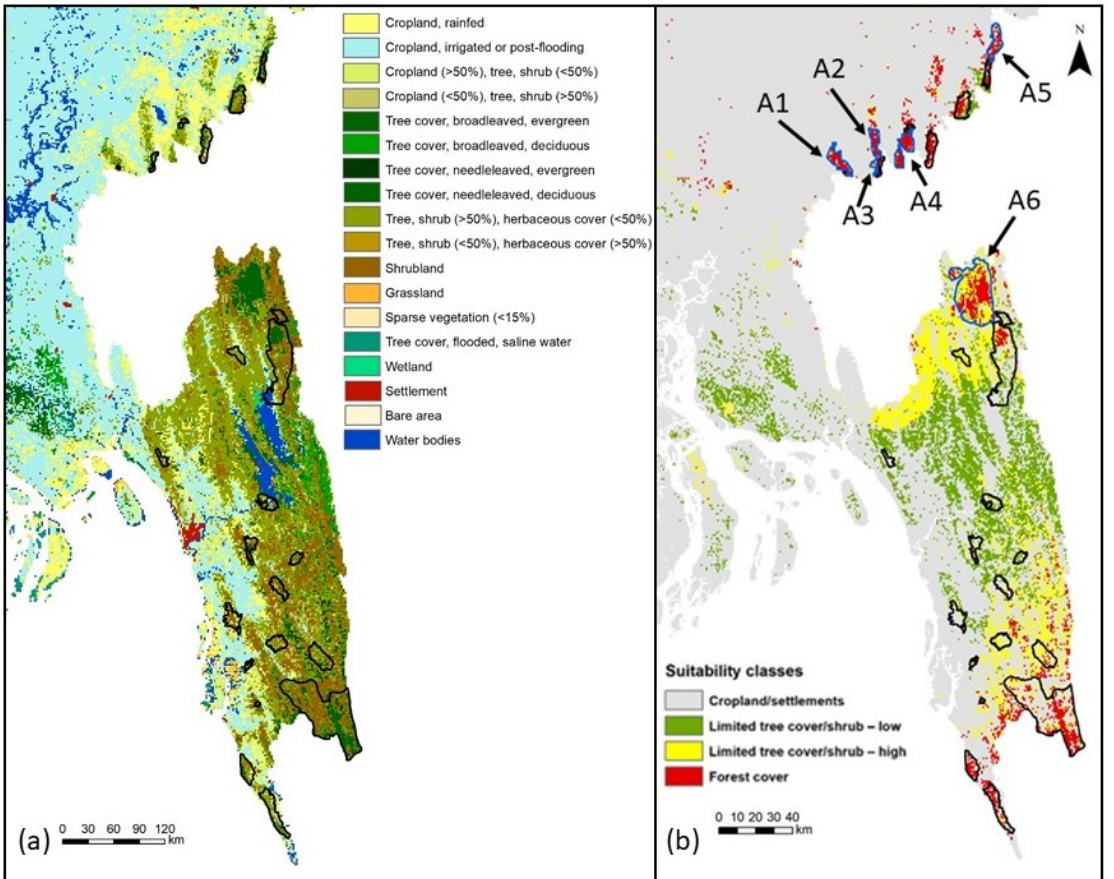
Figure 3. ( a ) Map showing forest distribution in eastern Bangladesh based on land-use/land-cover (version 2.1.1, ESA 2021) and ( b ) potential distribution of hoolock gibbons based on habitat quality (LULC), elevation and bioclimatic variables generated using MaxEnt modeling. The study sites are indicated with black outlines.